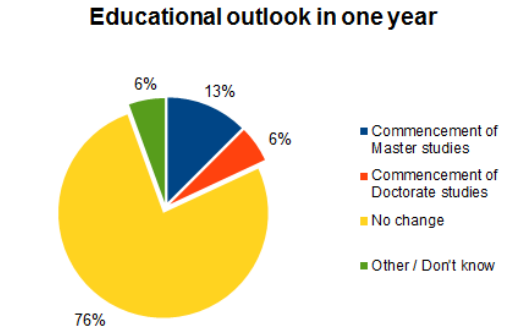
Figure 33 - Educational aspirations in the field of archaeology in one year